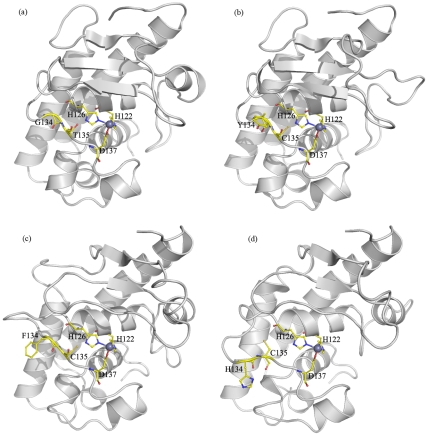
Homologous modeling of respective M35 family proteases in Coccidioides.(a)Mep 4; (b) Mep 2; (c) Mep7; (d) Mep8. The three catalytic zinc-binding residues and the two putative positive selected sites are shown as ball-and-stick models. Atoms are coloured with carbon in yellow, oxygen in red, nitrogen in blue and zinc in gray. All molecules are aligned in the same orientation.